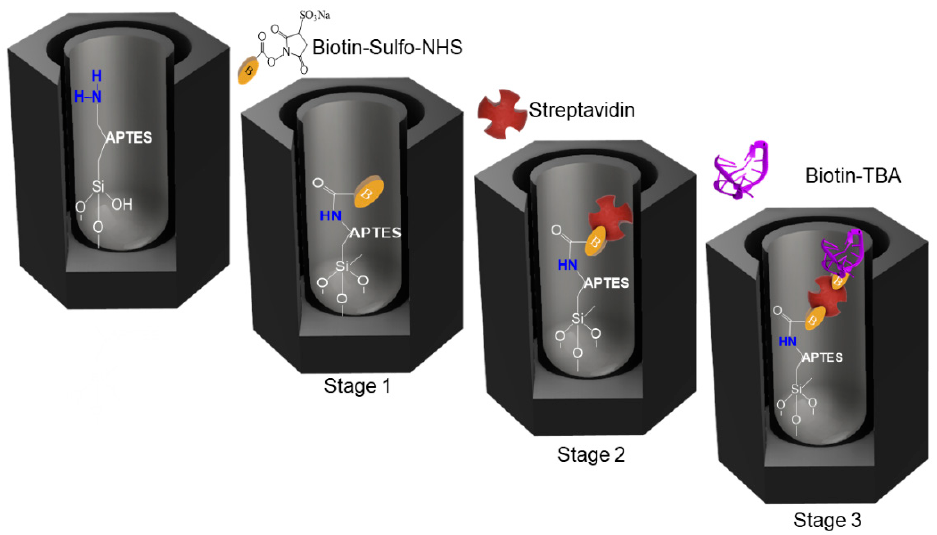
Figure 3. Schematics of aptamer immobilization into NAA pores.